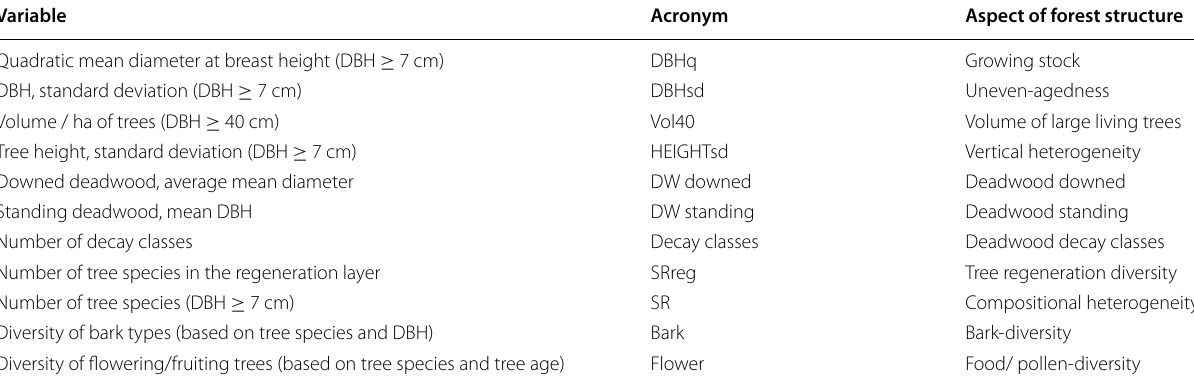
Table 2 Variables of forest structure, which are used in the forest structure index, and the aspects of forest structure they represent (taken from Storch et al.